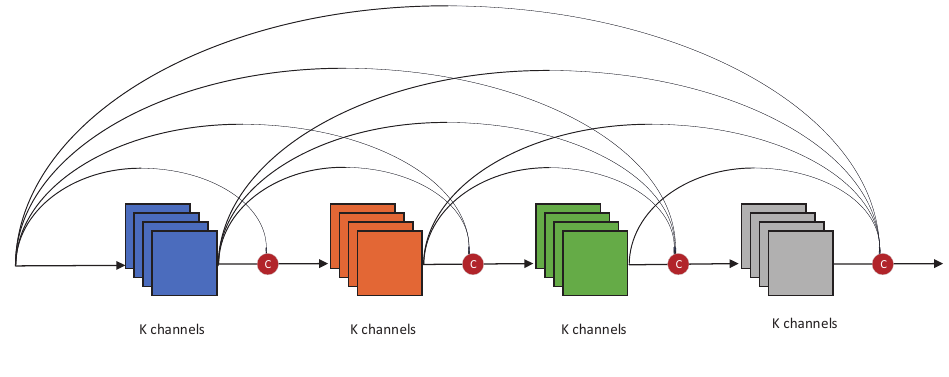
Figure 3. Structure of Dense Block.